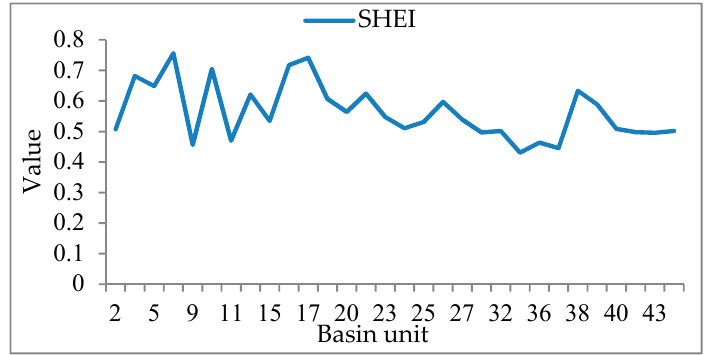
Figure 13. Diagram of Shannon’s evenness index (SHEI).